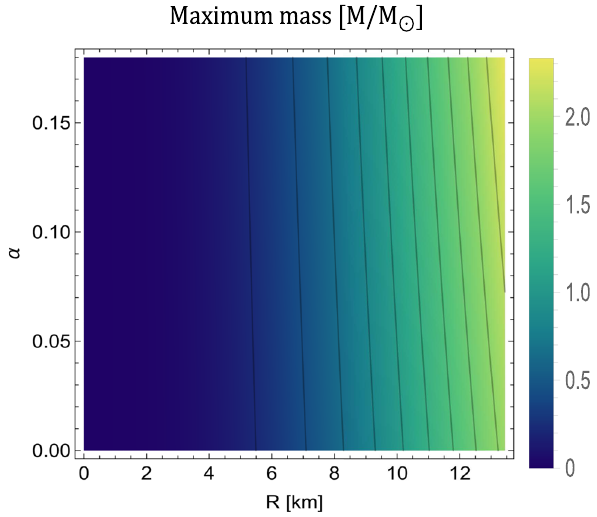
Fig. 6 The equi-mass diagram on R − α plane with constant value C = 0 . 0043 km − 2 , and β 1 = 0 . 66 km 2